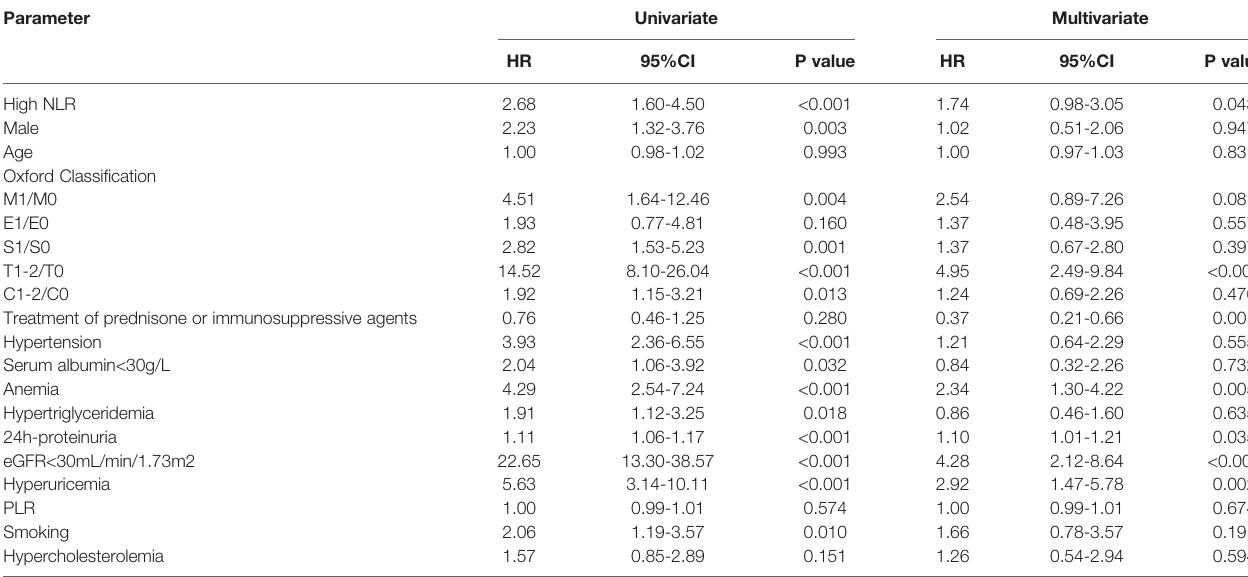
TABLE 3 | Univariate and multivariate Cox proportional hazard model for the renal outcome in 966 IgAN patients.